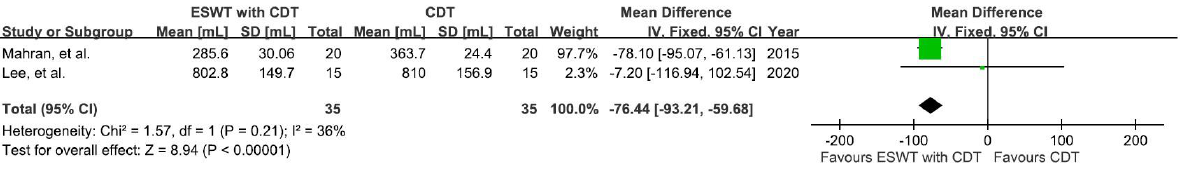
Figure 4. Mean difference (95%CI) in the effect of additional ESWT compared with CDT alone on the volume of BCRL.